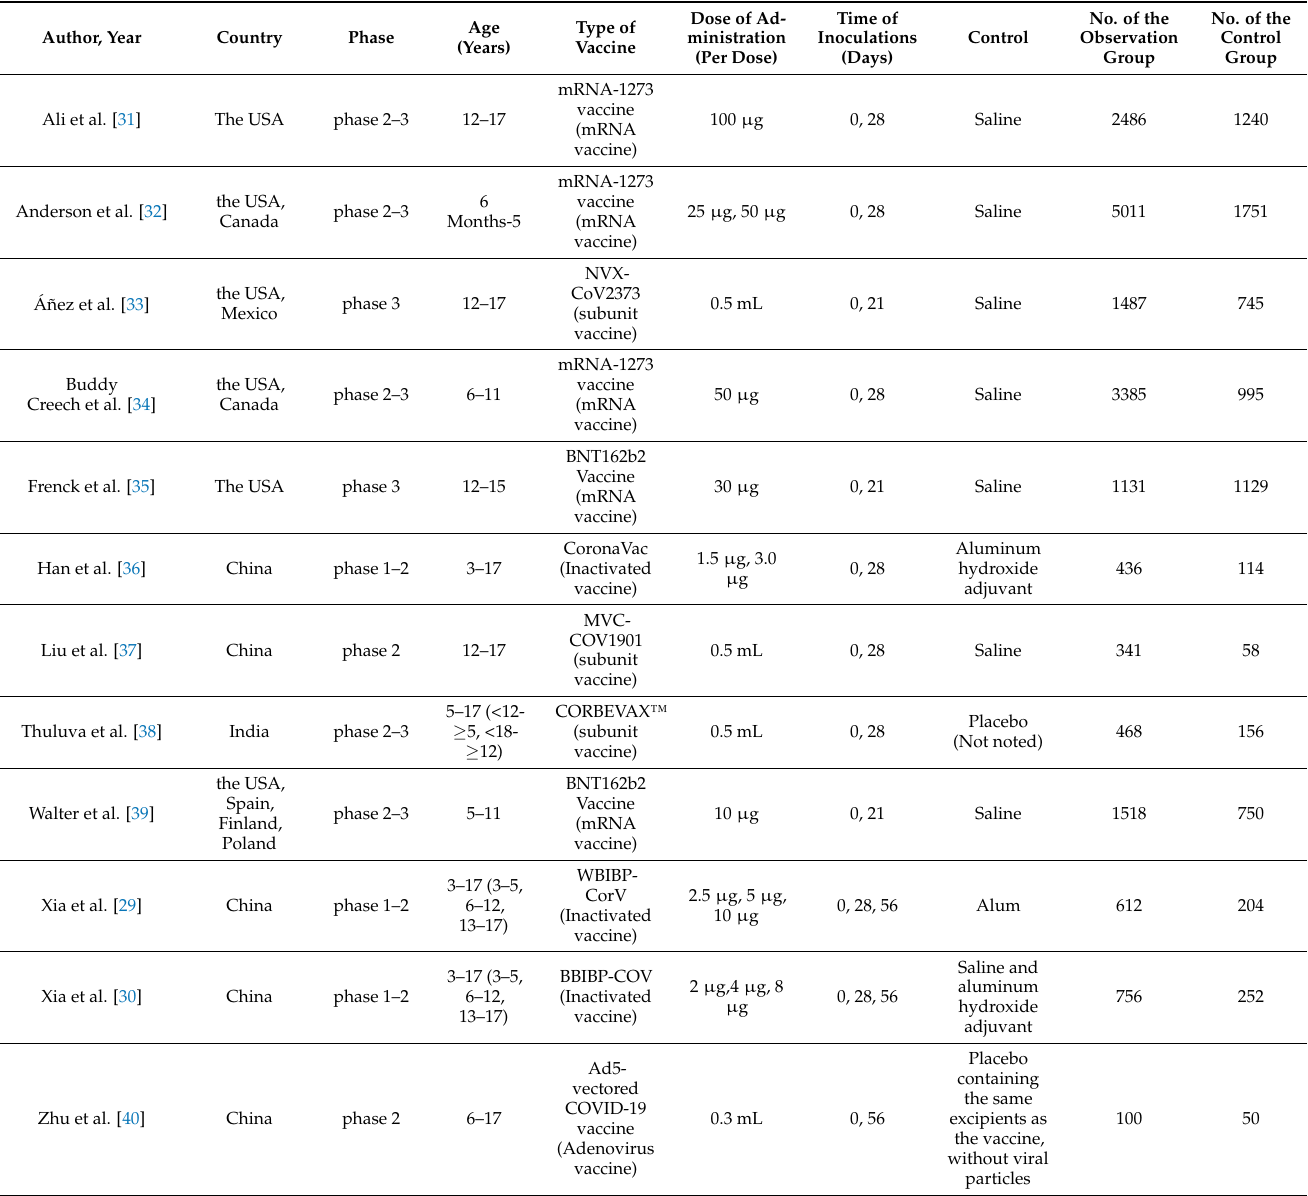
Table 2. The characteristics of the included